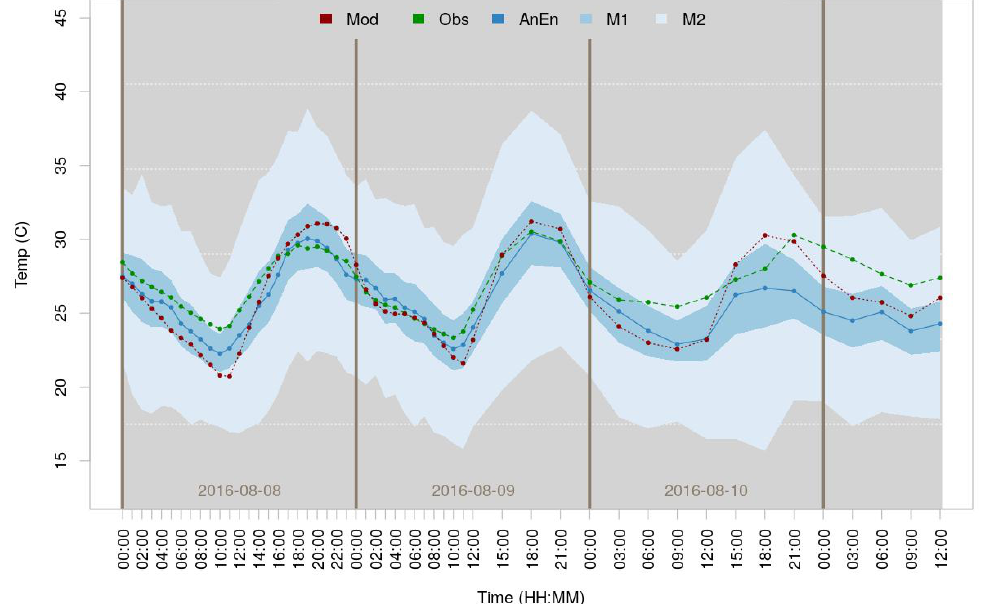
Figure 6. AnEn temporal representation of the downscaled forecast for 8 August 2016. The figure shows the original hourly NAM-NMM forecast (red dotted line), the average PWSs interpolated accordingly with the NAM-NMM model (green dotted), the AnEn ensemble mean (blue dotted), and the M1 and M2 points (shaded